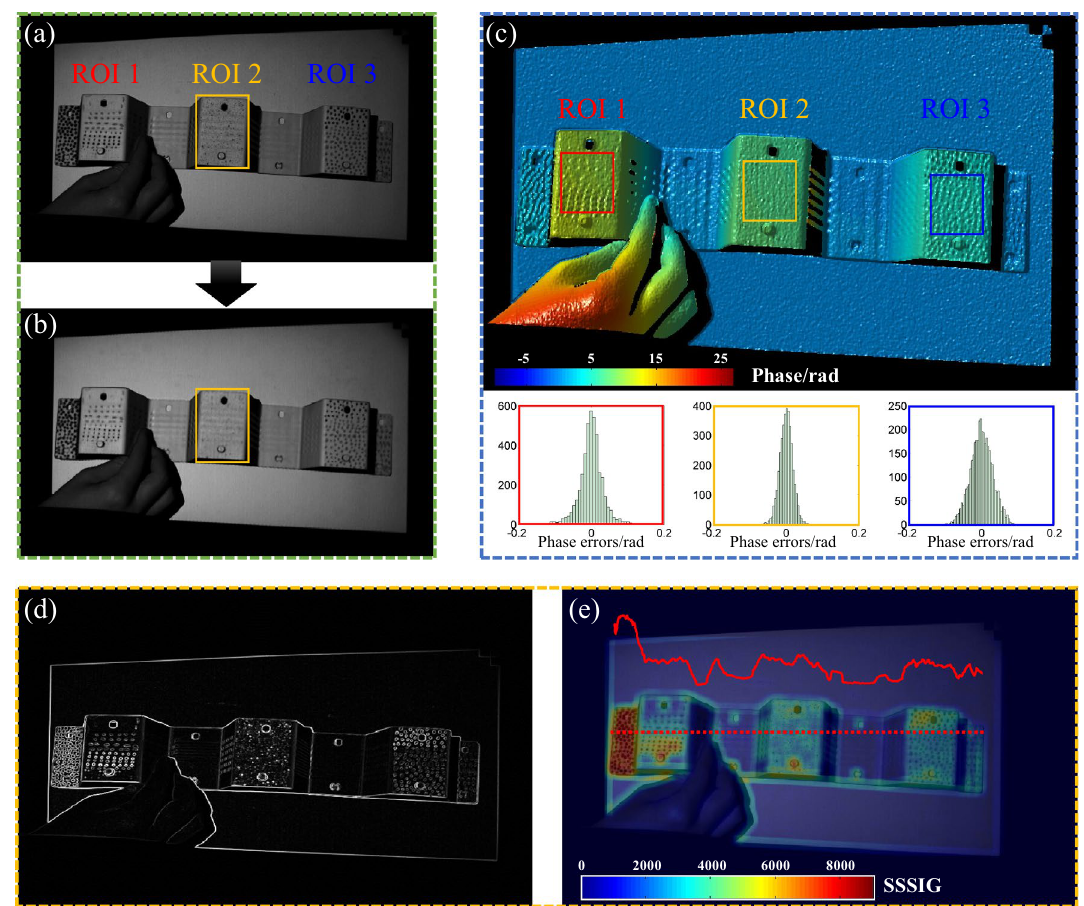
Figure 5. Comparative experiment on shape and deformation measurement accuracy using different speckle patterns. ( a ) Extracted texture pattern from phase-shifting patterns. ( b ) Texture pattern after median filtering. ( c ) Reconstructed phase and errors distribution in three regions. ( d ) Intensity gradients of tested specimen. ( e ) SSSIG of tested